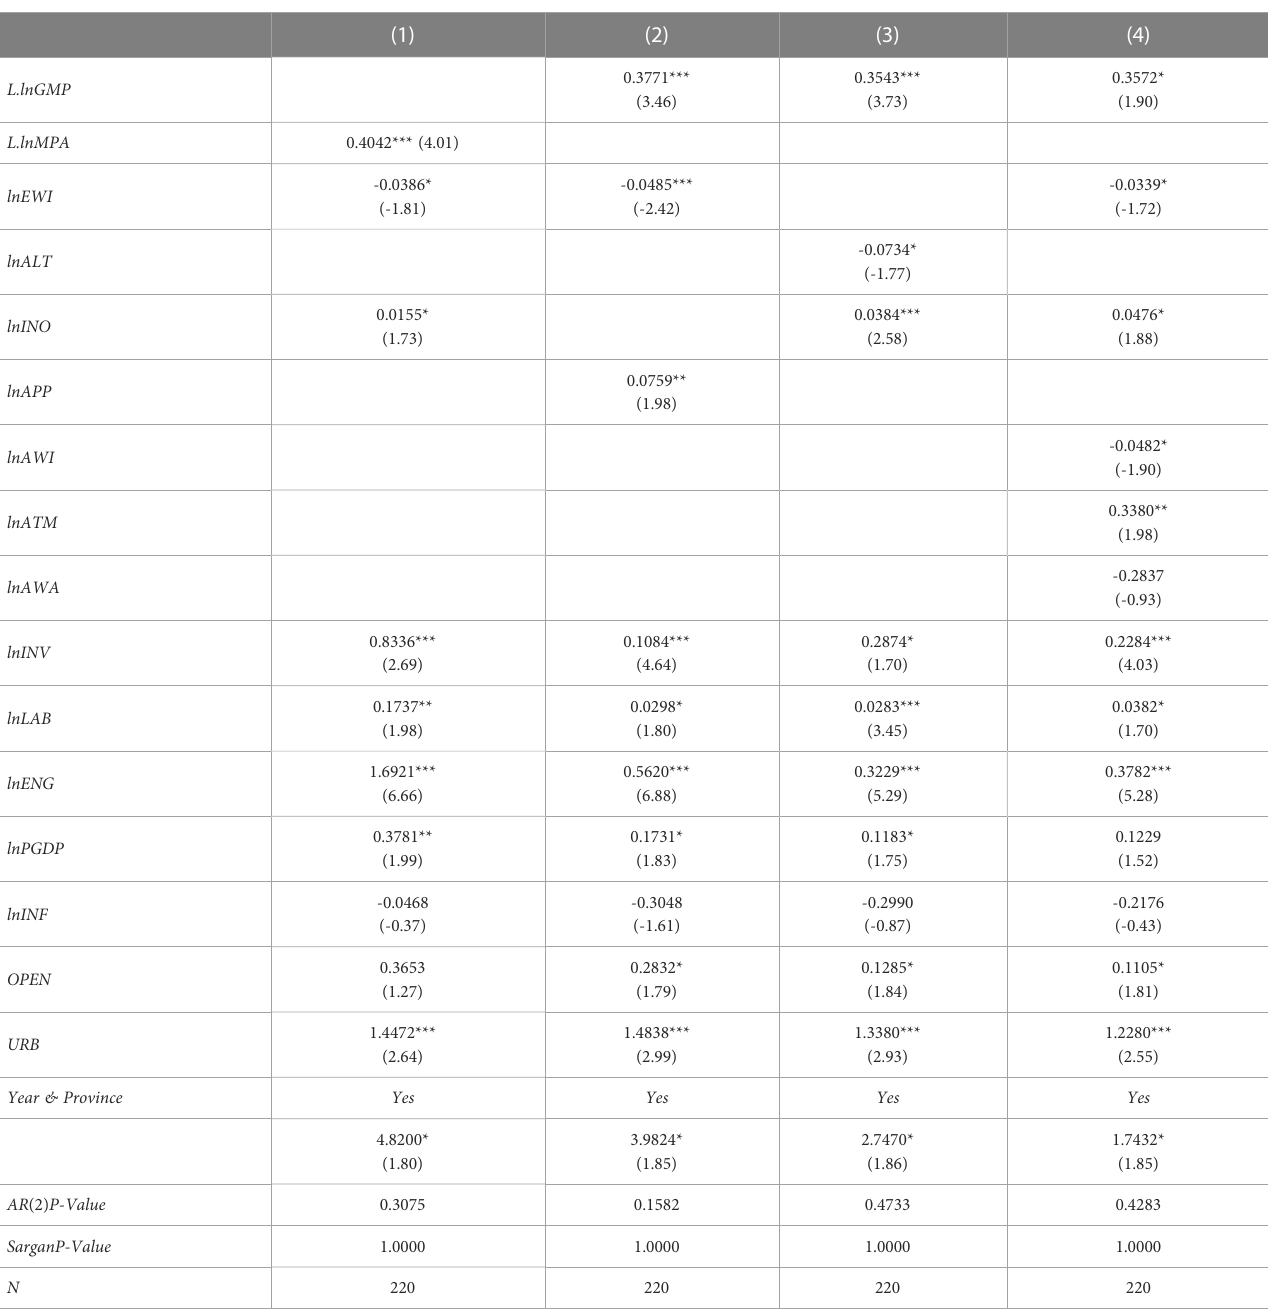
TABLE 6 Robustness test